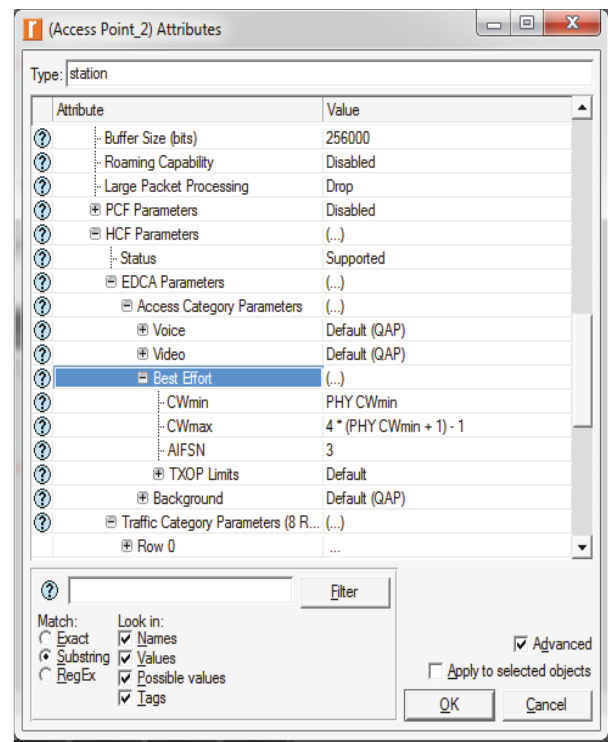
Figure 32: Default values of CWmin and CWmax.